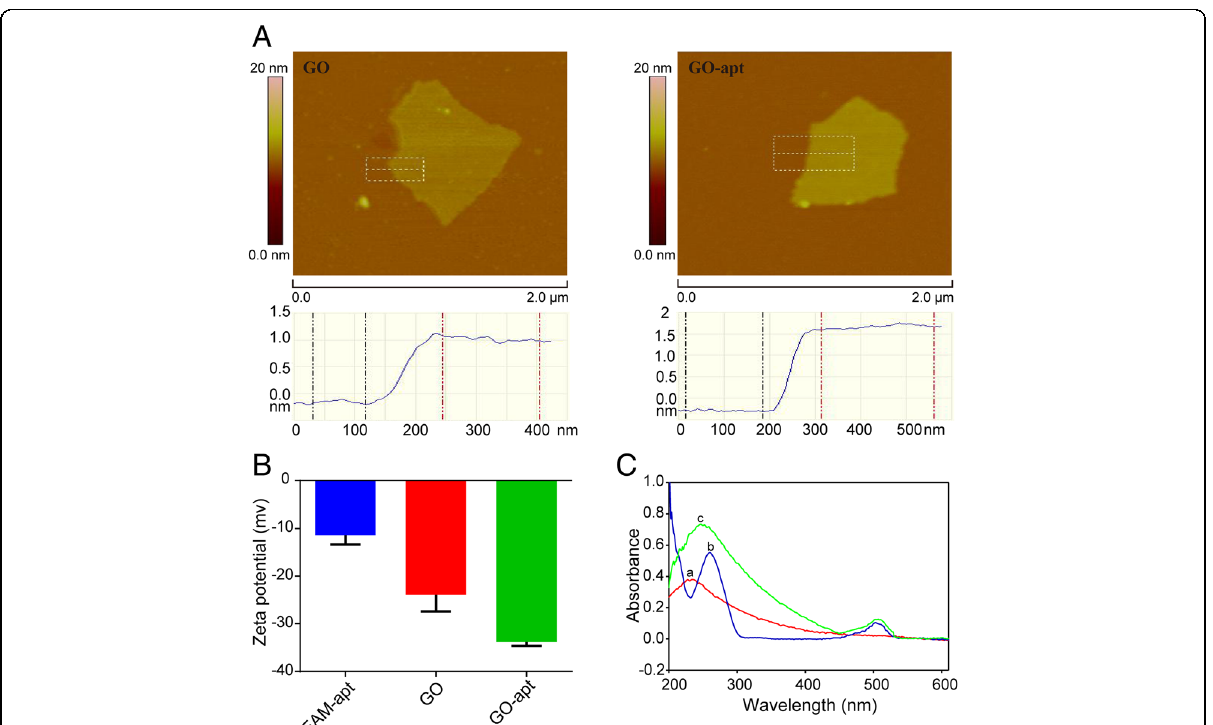
Fig. 3 Characterization of GO-apt. a AFM images of GO and CEM-apt. b Surface zeta potential of FAM-apt, GO, and CEM-apt. Error bars indicate ± SD ( n = 3). c UV-visible absorbance spectra of (a) GO, (b) FAM-apt, and (c) GO-apt